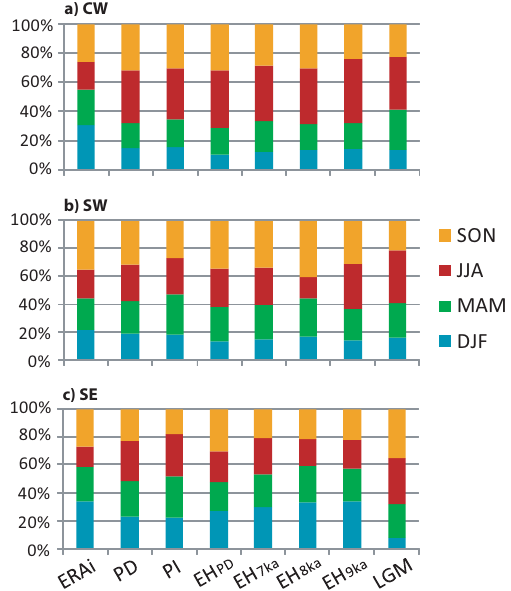
Fig. 9. Seasonal contribution to annual accumulation variability of the accumulation records in the (a) CW, (b) SW, and (c) SE region for ERAi and all simulations. Note that these seasonal contributions are calculated as standard deviations of the according seasonal mean accumulation time series. They are all expressed as relative portions of